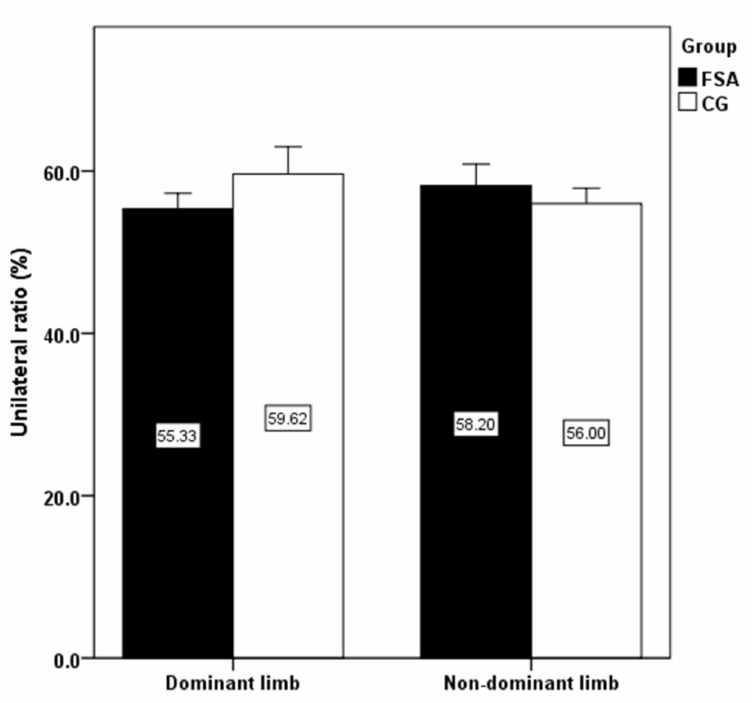
Figure 4. Comparison of unilateral strength ratio differences between groups. Note: FSA: fire sports athletes; CG: control